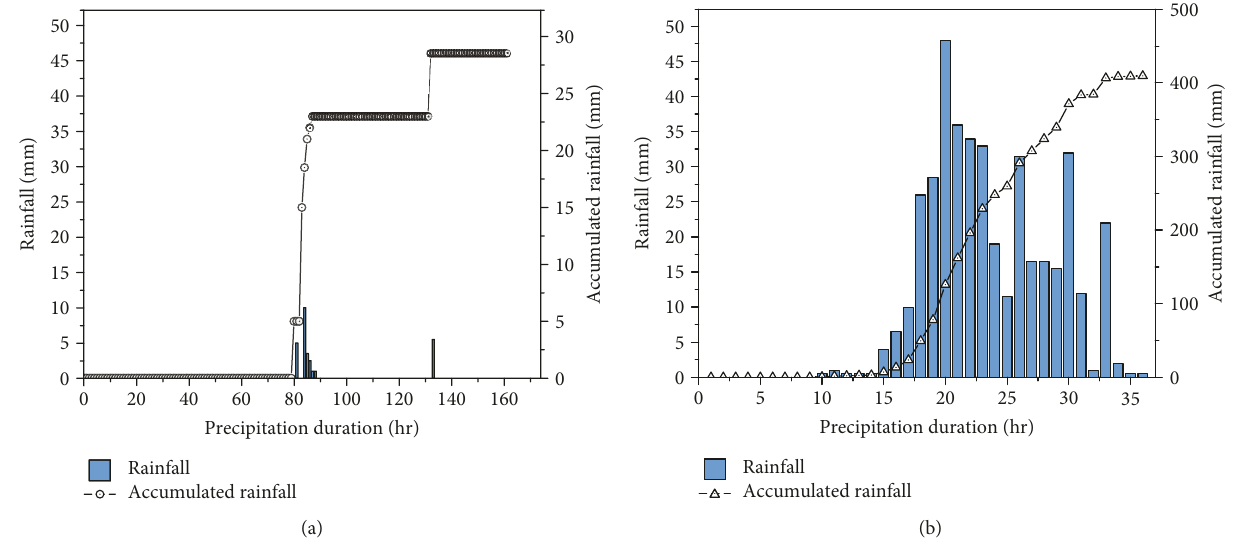
Figure 6: (a) The antecedent rainfall data used in FEA and (b) the typhoon rainfall data used in Table 1: The input geomaterial parameters in FEA.